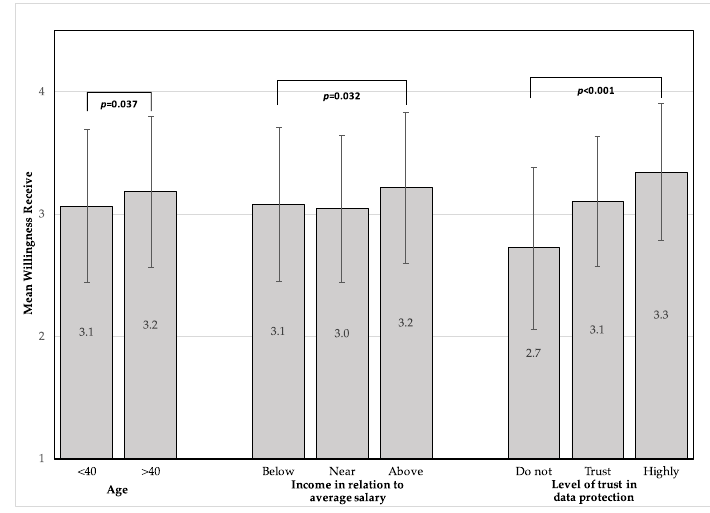
Figure 1. Differences in mean willingness to receive medical services through remote communications in times of emergencies. Error bars represent standard deviation.